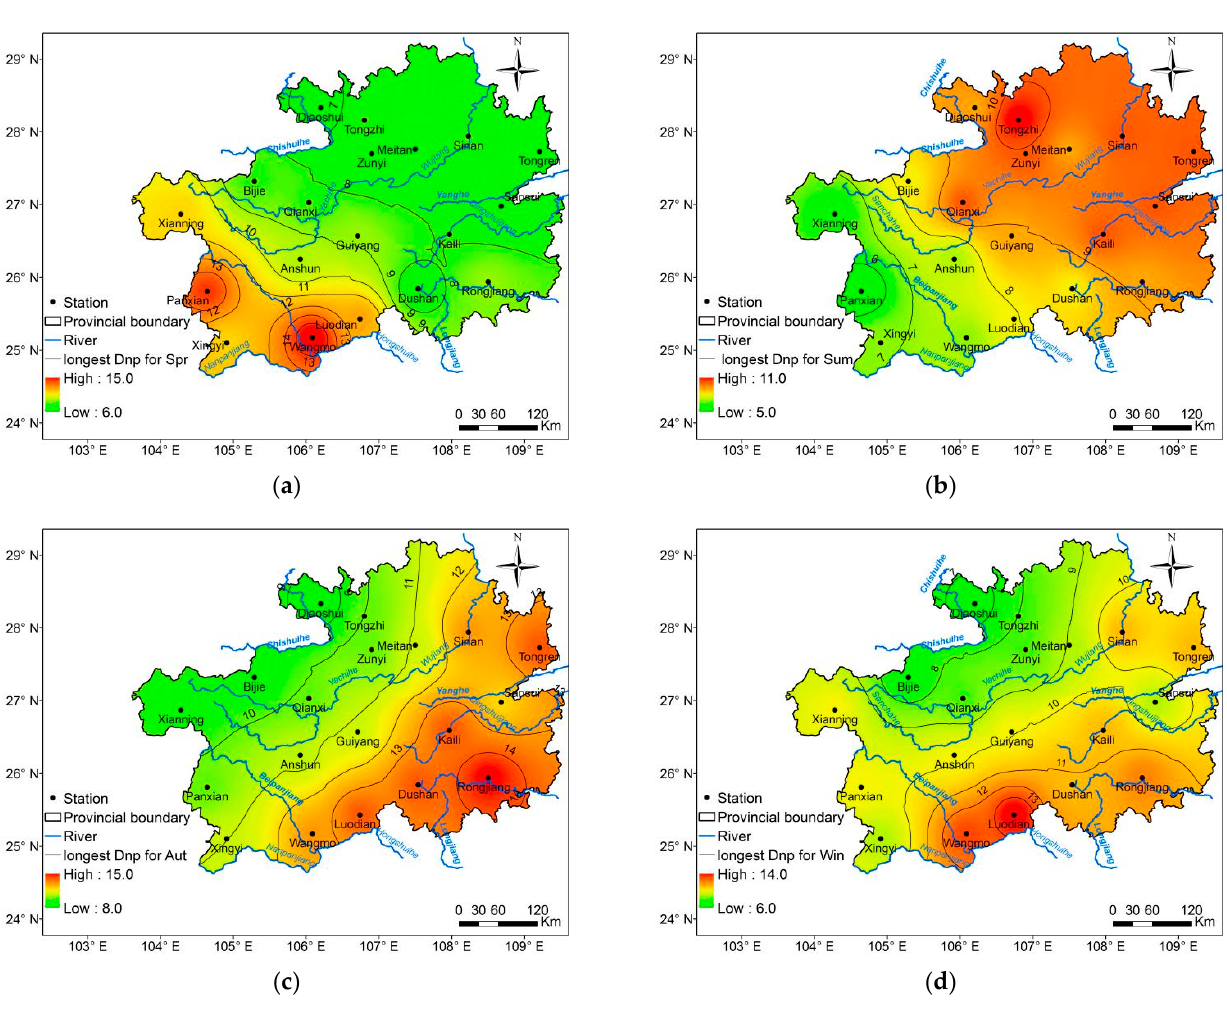
Figure 9. The spatial variations of average longest Dnp in ( a ) spring, ( b ) summer, ( c ) autumn, ( d ) winter.